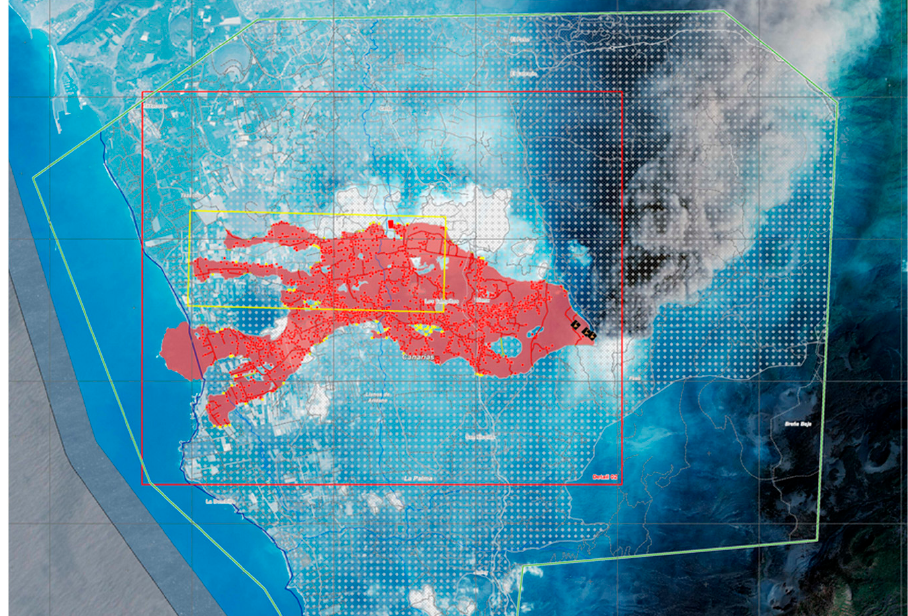
Figure 1. Image of the palm eruption by the Copernicus Emergency Management Service (European Union (2021) [2].